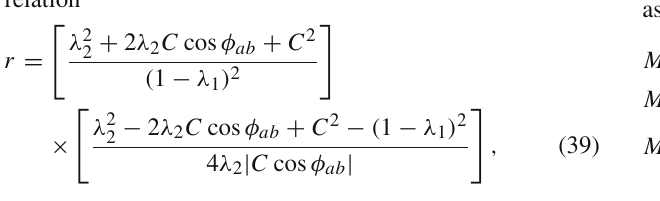
and the ratio of the mass-squared differences r satisfies the